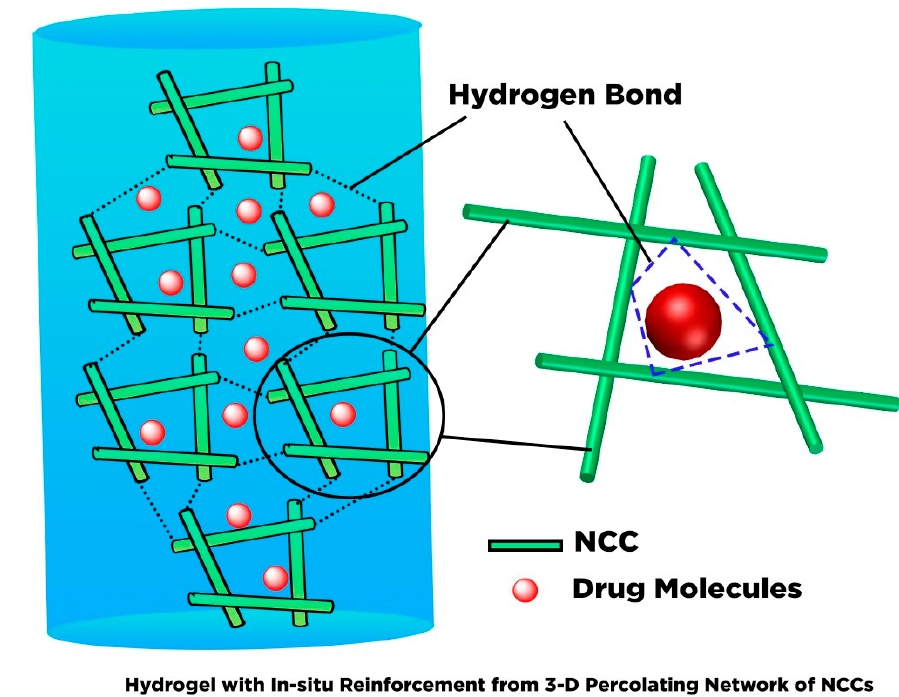
Figure 12. Schematic illustration of possible locking effect of the drug via host–guest inclusion in supramolecular hydrogel constructed from cyclodextrin and chemically modified nanocrystalline cellulose (this picture is redrawn from [178]. Copyright © 2013 American Chemical Society.)